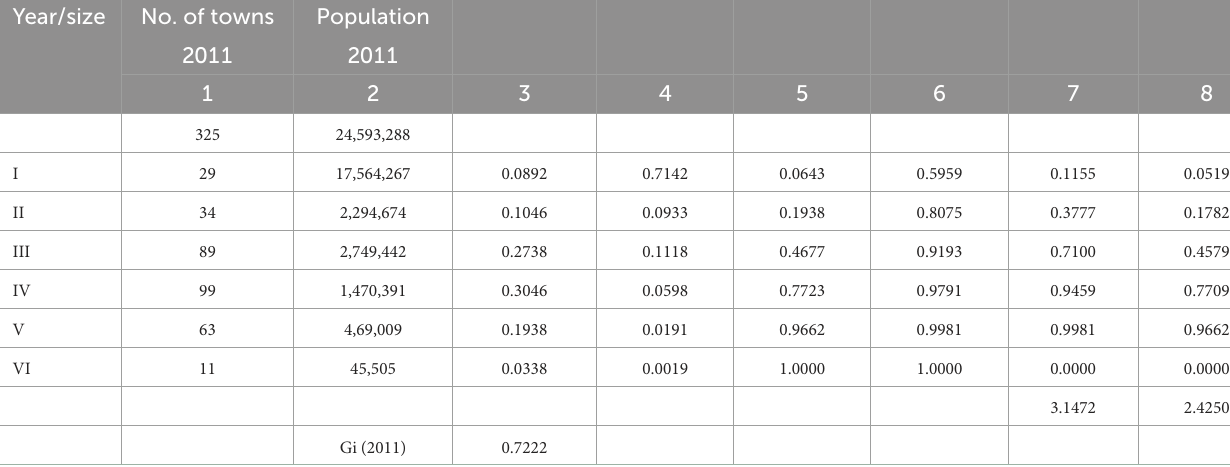
TABLE 5 Gini co-efficient of size class